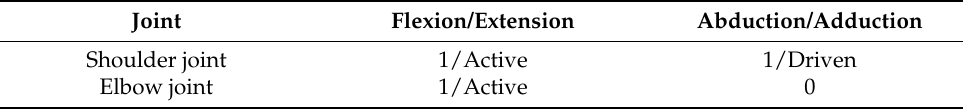
Table 1. The degree of freedom (DoF) configuration and movement form scheme.